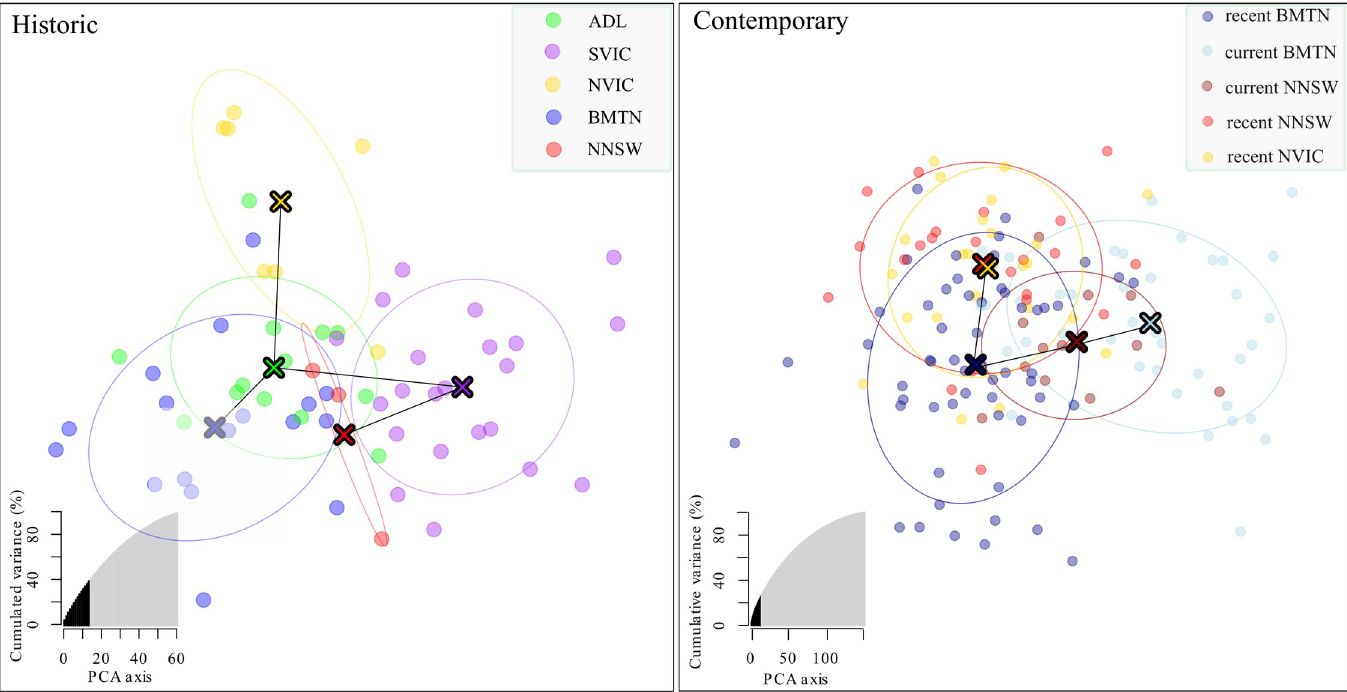
Fig 2. Discriminant analysis of principle component (DAPC) plots for historic and contemporary regent honeyeater samples by a-priori populations. Inset figures show proportion of total variance explained with the number of retained principle components. See S10 Fig for associated assignment plots.